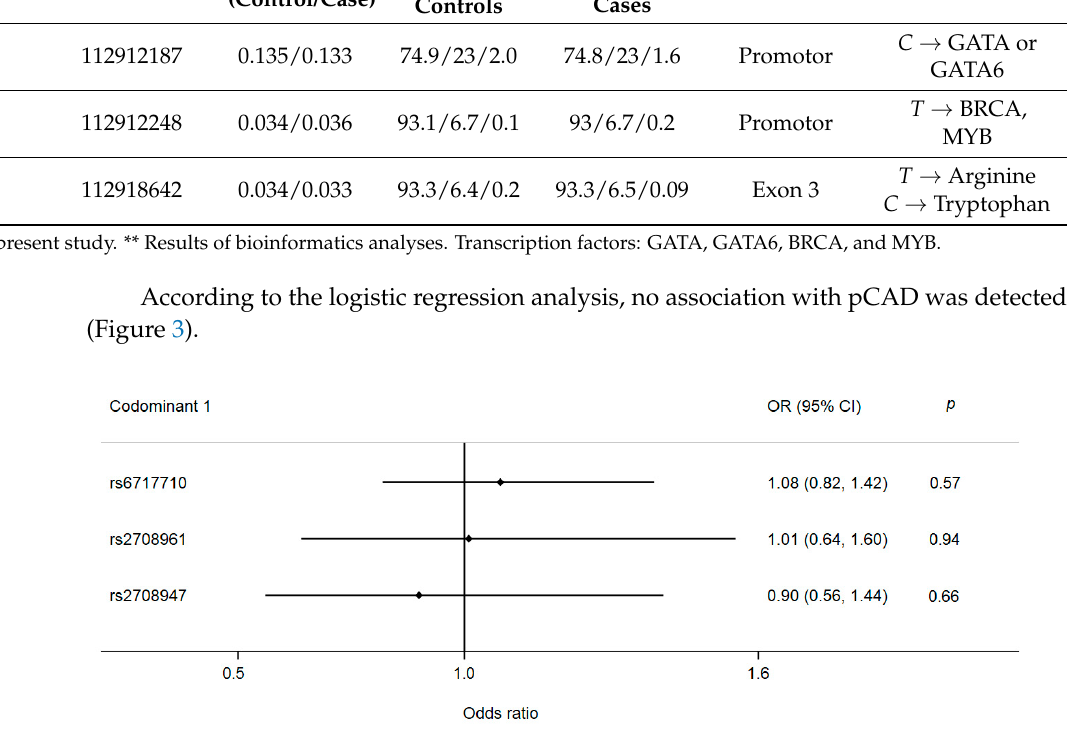
Figure 2. Prevalence of cardiovascular risk factors in the population studied. Data are presented in percentages. Significant p value * <0.05; ** <0.001. TC = total cholesterol; HA = Hypoalphalipopro- teinemia; Elevated LDL ≥ 130 mg/dL; DM = diabetes; HOMA-IR = Homeostatic Model Assessment for Insulin Resistance.